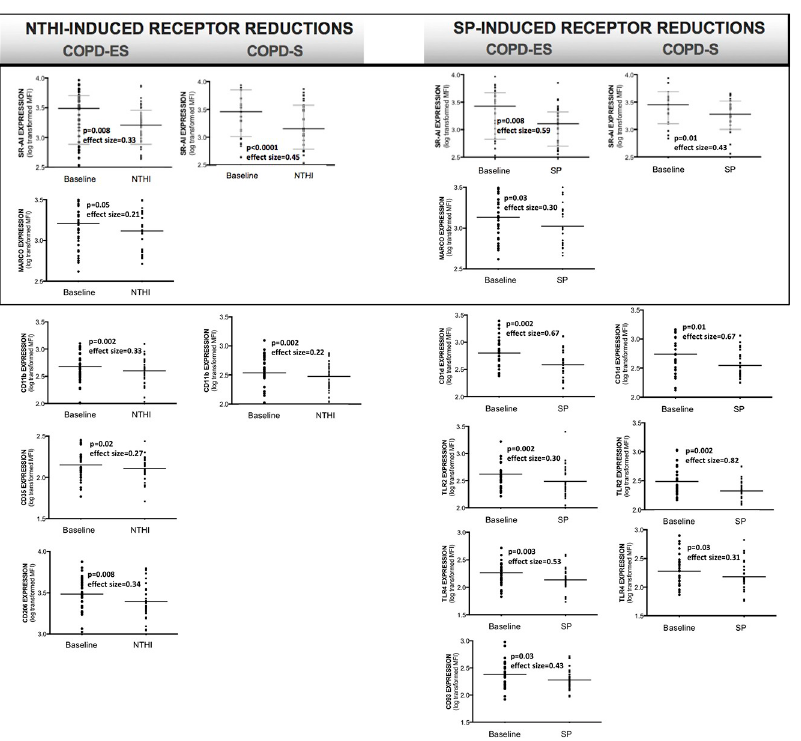
Fig 2. NTHI and SP-mediated reductions of bacterial recognition receptor expression on MDMs from subjects with COPD. Analysis by paired T-test of log-transformed receptor MFI (mean fluorescence intensity) representative of cell surface receptor density, as compared to baseline receptor expression. Boxes around SR-AI and MARCO denote the only receptors reduced by both NTHI and SP. Receptor expression is presented as an aligned dot-plot with thin black bar at the mean, flanking short grey bars delineating the SD. Effect size calculated by Cohen’s-d calculation. S3 Fig provides additional heat map format of statistically significant NTHI- and SP-induced reductions in bacterial recognition receptors.